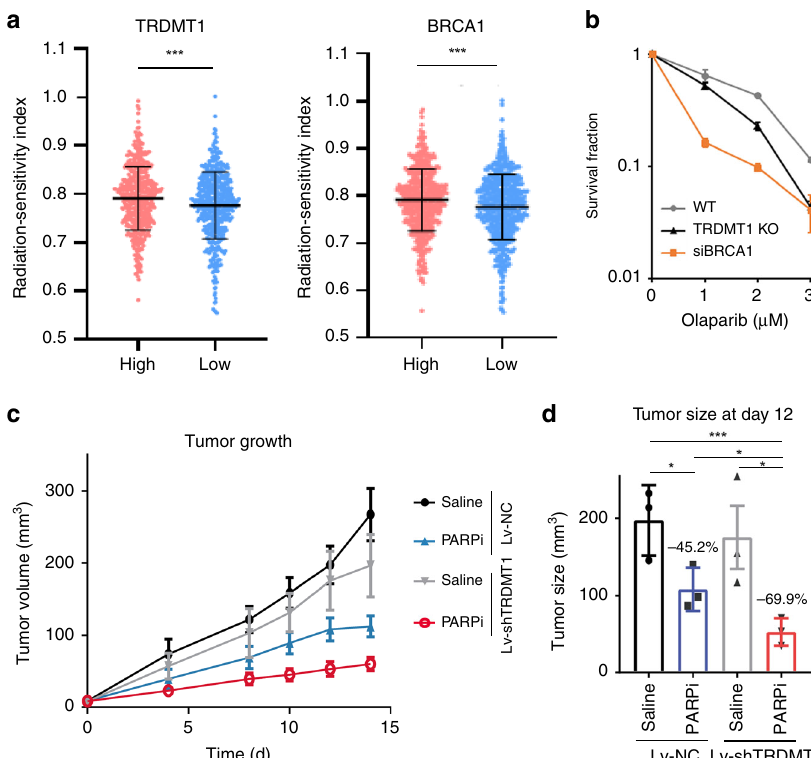
Fig. 5 TRDMT1 inhibition sensitizes cells to radiation and PARPi. a Clinical and RNA-seq gene expression data were downloaded from TCGA. RSI was calculated by a rank-based linear regression algorithm. The median value of BRCA1 and TRDMT1 TPM was de fi ned as the cutoff to classify patients into high expression and low expression groups ( n = 1091, mean ±SD). b WT, TRDMT1 KO U2OS, or siBRCA1 cells were treated with Olaparib at the indicated dose. The survival rate was measured via the colony formation assay ( n = 3, mean ± SEM). c Tumor volume in mice injected with LV-shTRDMT1 or LV-NC pre-treated MDA-MB-231 cells at the indicated time ( n = 3, mean ± SEM). One week after injection, 50 mg/kg Olaparib or saline was intraperitoneally injected into the xenograft tumors once every other day. d Tumor volume in mice injected with LV-shTRDMT1 or LV-NC pre-treated MDA-MB-231 cells at day 12 after PARPi treatment ( n = 3, mean ± SEM). Statistical analysis was performed with the unpaired two tailed Student ’ s t -test. * p < 0.05; ** p < 0.01; *** p < 0.001; **** p <